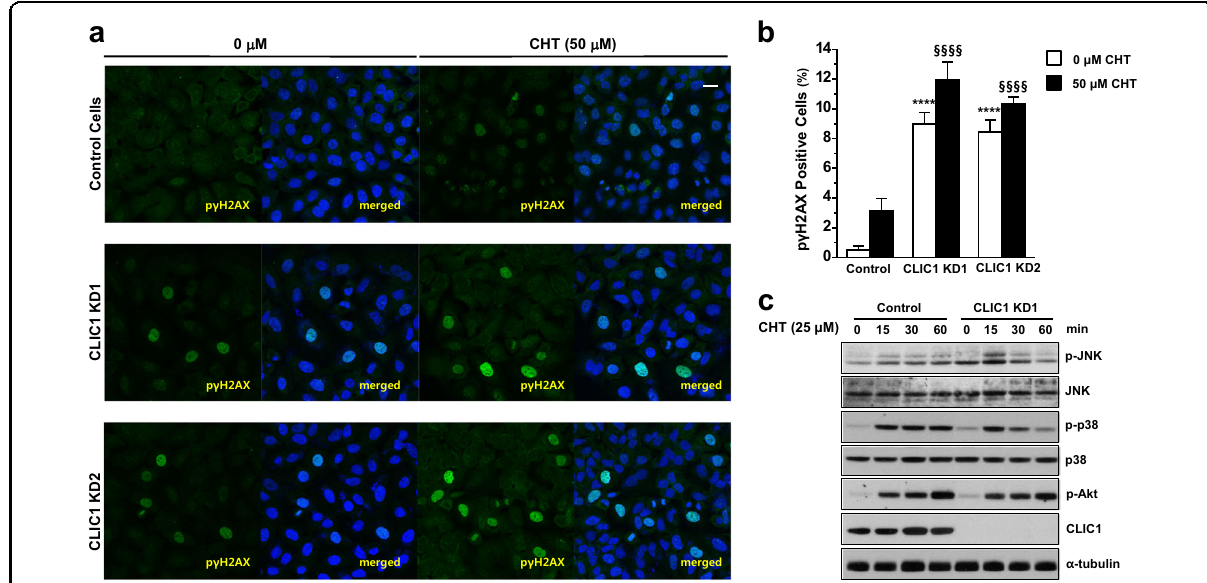
Fig. 1 CLIC1 knockdown exacerbated the cellular stress response in A549 cells. a A549 cells were stimulated with vehicle or 50 μ M chelerythrine for 24 h. Representative images showing p γ H2AX (Ser140) (green) and Hoechst-stained nuclei (blue). Scale bar, 20 μ m for all images. b Quanti fi cation of p γ H2AX (Ser140)-positive cells. At least 400 – 900 cells were counted for each condition (Supplementary Table S1). **** P < 0.0001 (control vs CLIC1 KD with vehicle) or §§§§ P < 0.0001 (control vs CLIC1 KD with chelerythrine stimulation) by ANOVA with Tukey ’ s test ( P < 0.05). c Depletion of CLIC1 activated MAPK differentially under ROS exposure. A549 cells were stimulated with 25 μ M chelerythrine for the indicated times. The protein levels of mitogen-activated protein kinases (MAPKs), including JNK and p38, Akt and CLIC1, were determined by immunoblot analysis. Data from three independent experiments are